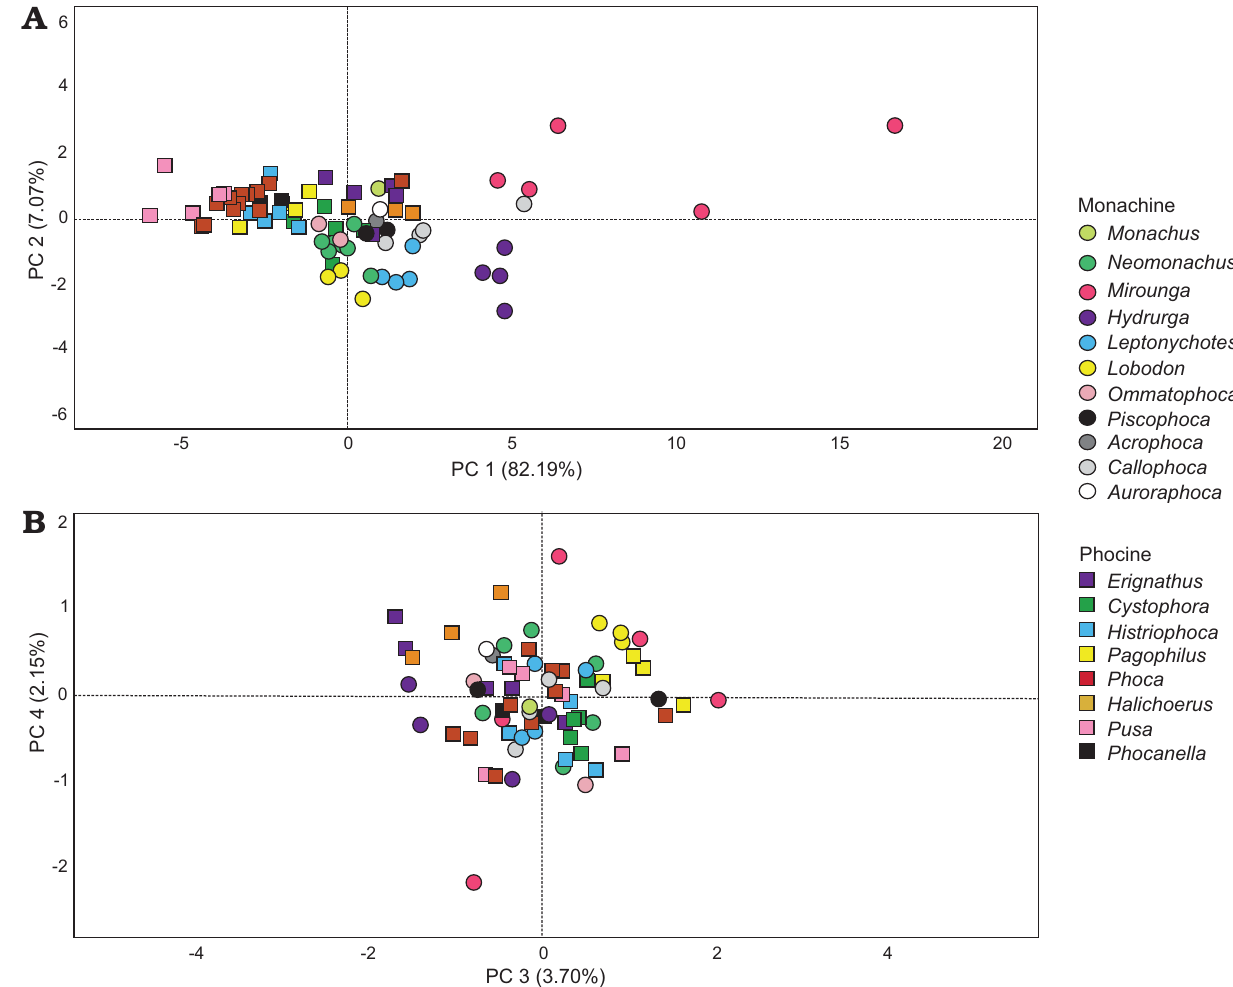
Fig. 3. Results of PCA for the humerus measurement data, including extant and fossil earless seal taxa. A . PC1 vs. PC2. B . PC3 vs.